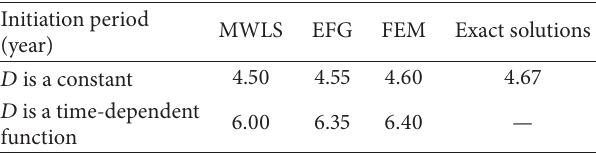
Table 3: The initiation period of corrosion by different methods (at 31